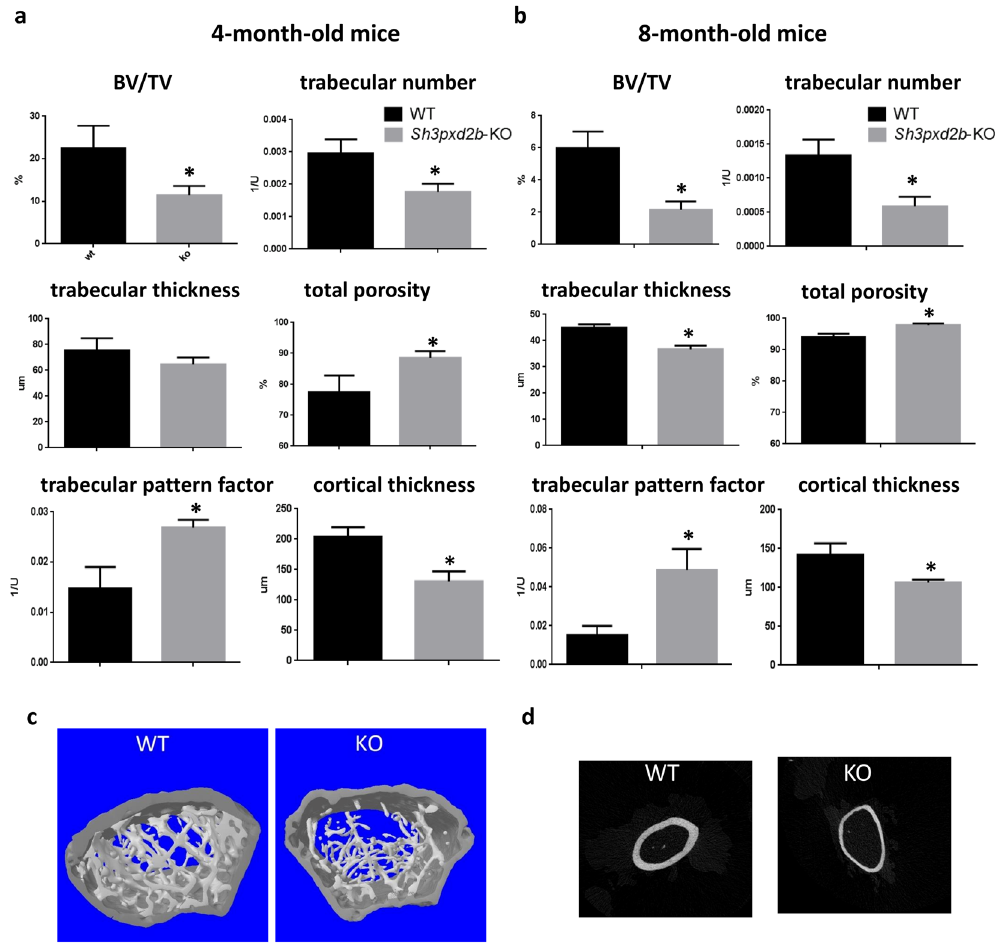
Figure 2. Bone architecture measurements of Sh3pxd2b -KO mice. ( a ) Analysis of the trabecular microarchitecture in 4-month-old wild type and Sh3pxd2b -KO mice based on Micro-CT data. The data are shown as the mean ± SEM of three mice in each group. ( b ) Micro-CT-based analysis of parameters describing the trabecular microarchitecture at a later time point (8 months old) measured in six wild type and six Sh3pxd2b -KO mice. Student’s t-test was used to assess the statistical significance of the difference between the means of the two groups. * p < 0.05. ( c ) 3D images of the trabecular region of the femurs isolated from 8-month- old wild type and Sh3pxd2b -KO mice. ( d ) Representative 2D images of the cortical bone at the femoral mid- diaphysis from 8-month-old wild type and Sh3pxd2b -KO